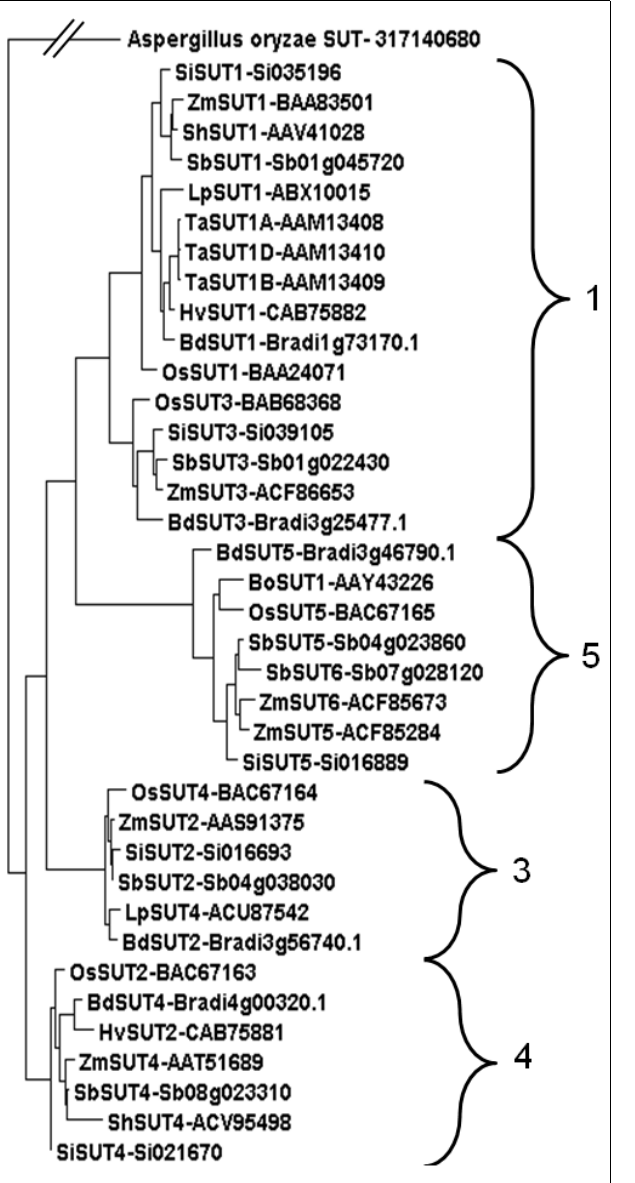
FIGURE 3 | Phylogenetic analysis of SUTs from monocotyledonous species. SUTs displayed fit into Groups 1, 3, 4, 5 (Braun and Slewinski,